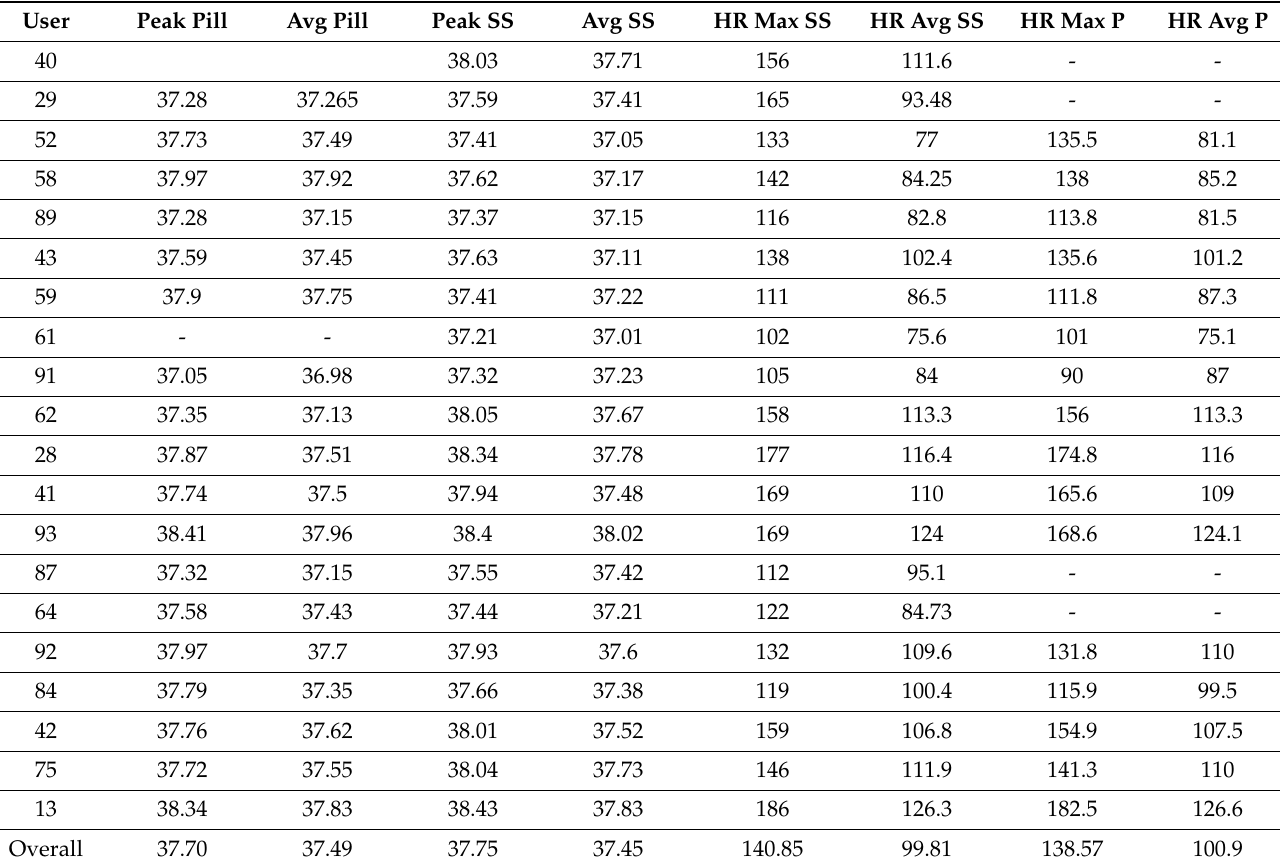
Table 2. Collected data for all